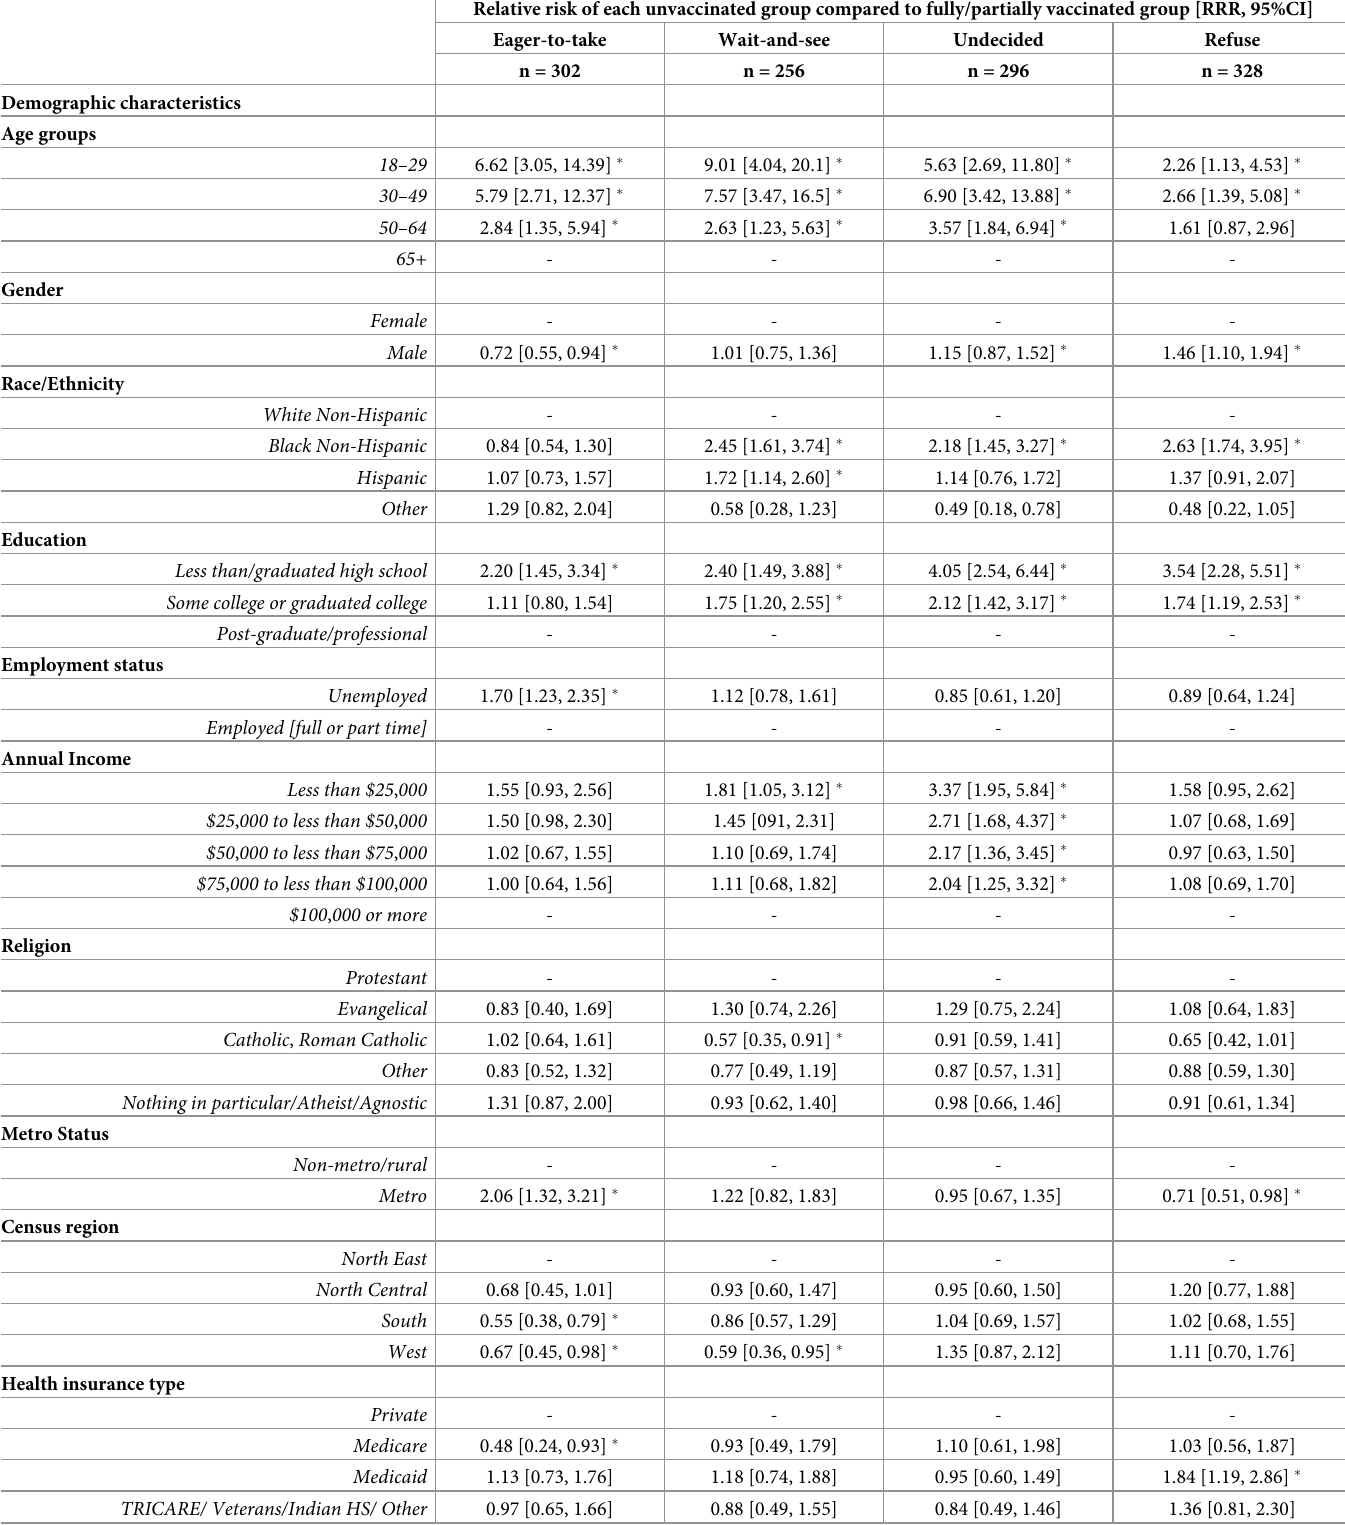
Table 3. Adjusted multivariable multinomial regression of unvaccinated groups compared to fully/partially vaccinated group as a reference category [n = 2899]. Relative risk of each unvaccinated group compared to fully/partially vaccinated group [RRR, 95%CI] Eager-to-take